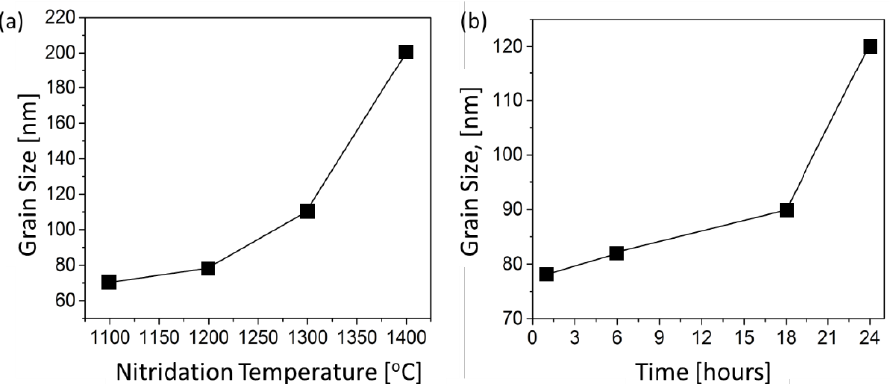
Figure 3. The effect of nitridation condition on the grain size of reacted powders. The grain size was measured from SEM. ( a ) Nitridation temperature vs. grain size for various temperature held for 1 h. ( b ) Holding time at 1200 °C vs. grain size.